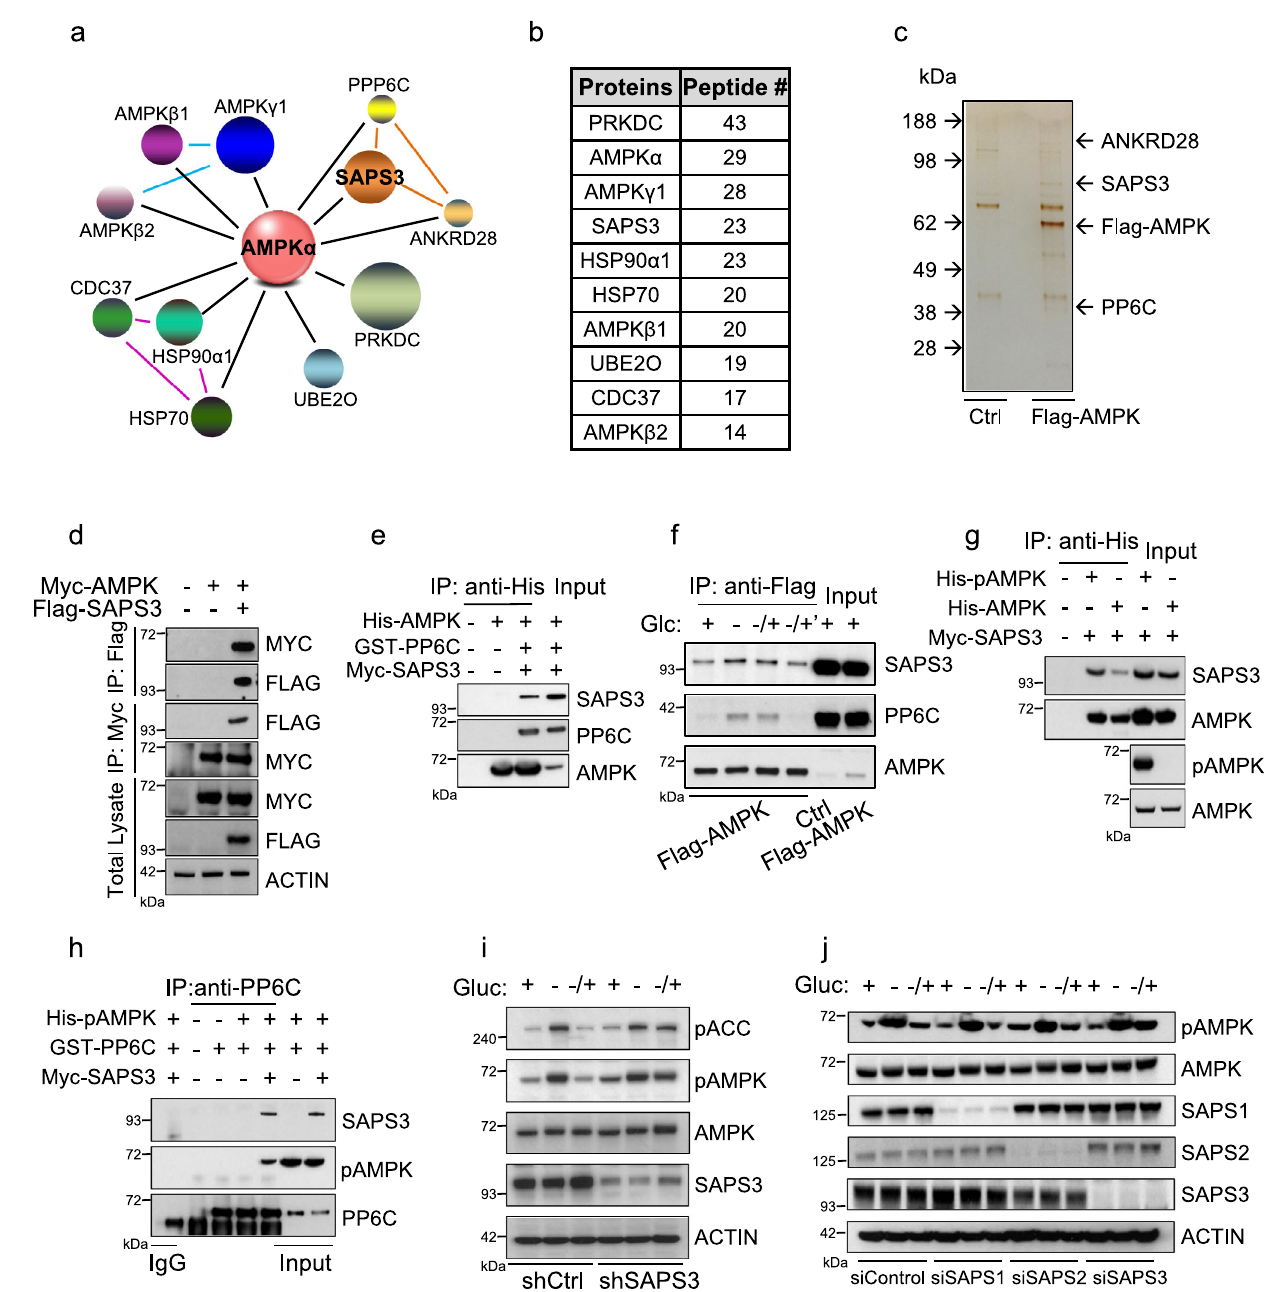
Fig. 1 | SAPS3 brings the PP6 catalytic subunit to dephosphorylate AMPK. a Schematic model of top binding proteins to AMPK by mass spectrometry. The bigger sphere representsmorebinding peptides to AMPK.Colored lines represent previously reported interactions. PRKDC, DNA-dependent protein kinase catalytic subunit; HSP90 α 1, heat shock protein 90 alpha 1; HSP70, heat shock protein 70; UBE2O, ubiquitin-conjugating enzyme E2 O; CDC37, cell division cycle 37; ANKRD28,ankyrinrepeatdomain28. b ThetopbindingproteinstoAMPKbymass spectrometry. c 293T cells were transfected with Flag-AMPK and treated with glucose deprivation and addback. Cell lysates were puri fi ed with anti-Flag beads and followed by silver staining. The result is representative of three independent experiments. d Flag-SAPS3 and Myc-AMPK were co-expressed in 293T cells. Cell lysates were immunoprecipitated with anti-Myc or anti-Flag beads followed by Westernblotting.Theresultsarerepresentativeofthreeindependentexperiments. e His-tag pull down of AMPK was performed followed by Western blotting using antibodies indicated. The results are representative of three independent